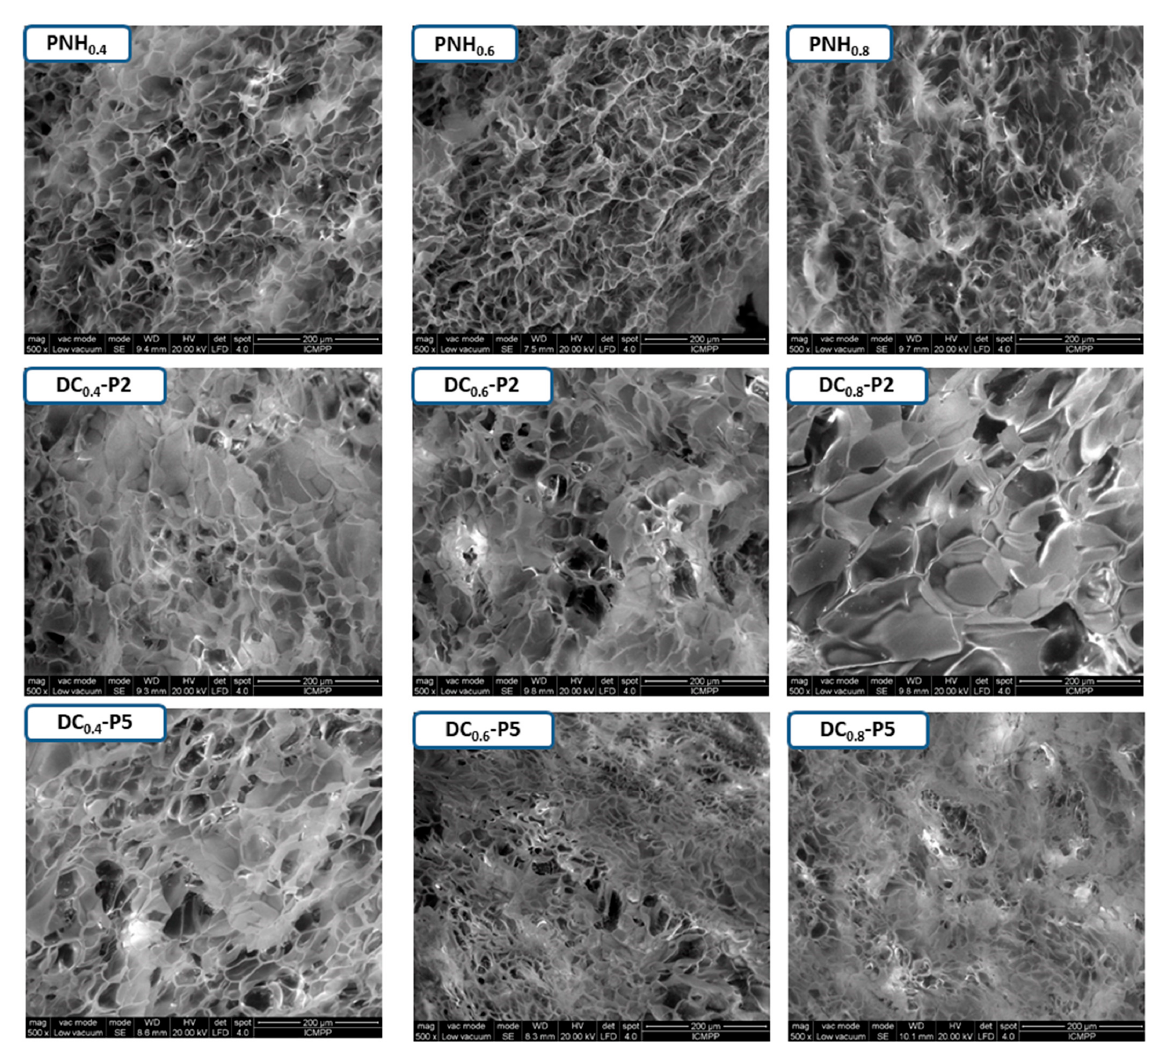
Figure 2. SEM micrographs of conventional and double cross-linked hydrogels. Magnification ×500. Table 2. The main characteristics of the most relevant DC hydrogels in comparison with conventional ones.